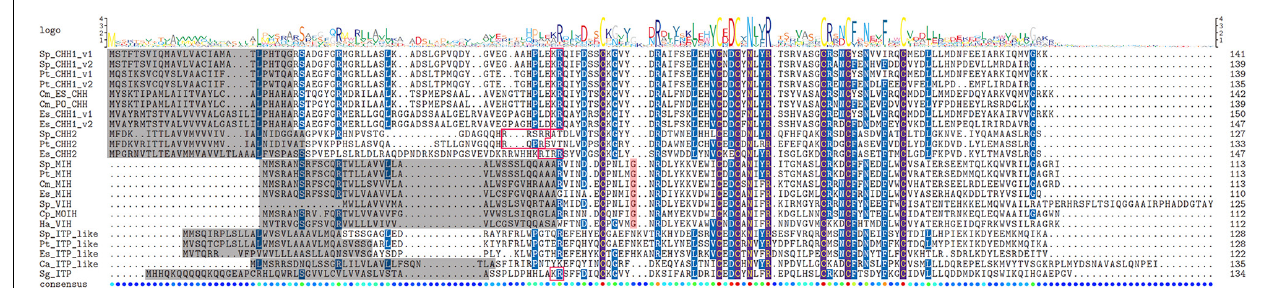
FIGURE 2 | Sequence alignment of CHHs precursors. Comparison of sequence alignment of CHH1-v1 , CHH1-v2 , CHH2 , MIH/VIH , and ITP-like peptide precursors in S. paramamosain, P. trituberculatus , and E. sinensis . Sequence logo of CHHs is shown above the alignment column. The gray highlighted represents signal peptide, pink highlighted represents the additional glycine of type II CHHs, red box represents the putative prohormone cleavage sites, the six conserved cysteines in the mature peptides were aligned and shown brown highlight.